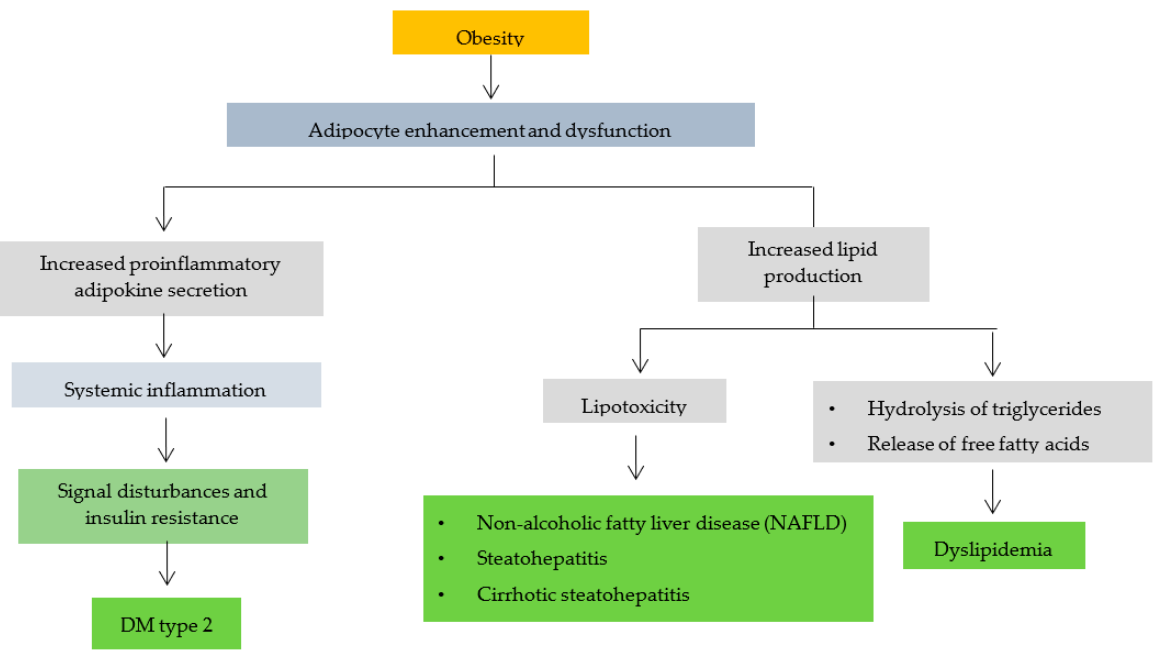
Figure 2. The relationship of obesity with other disease complications (modification of B. Heymsfield et al., 2017) [81].